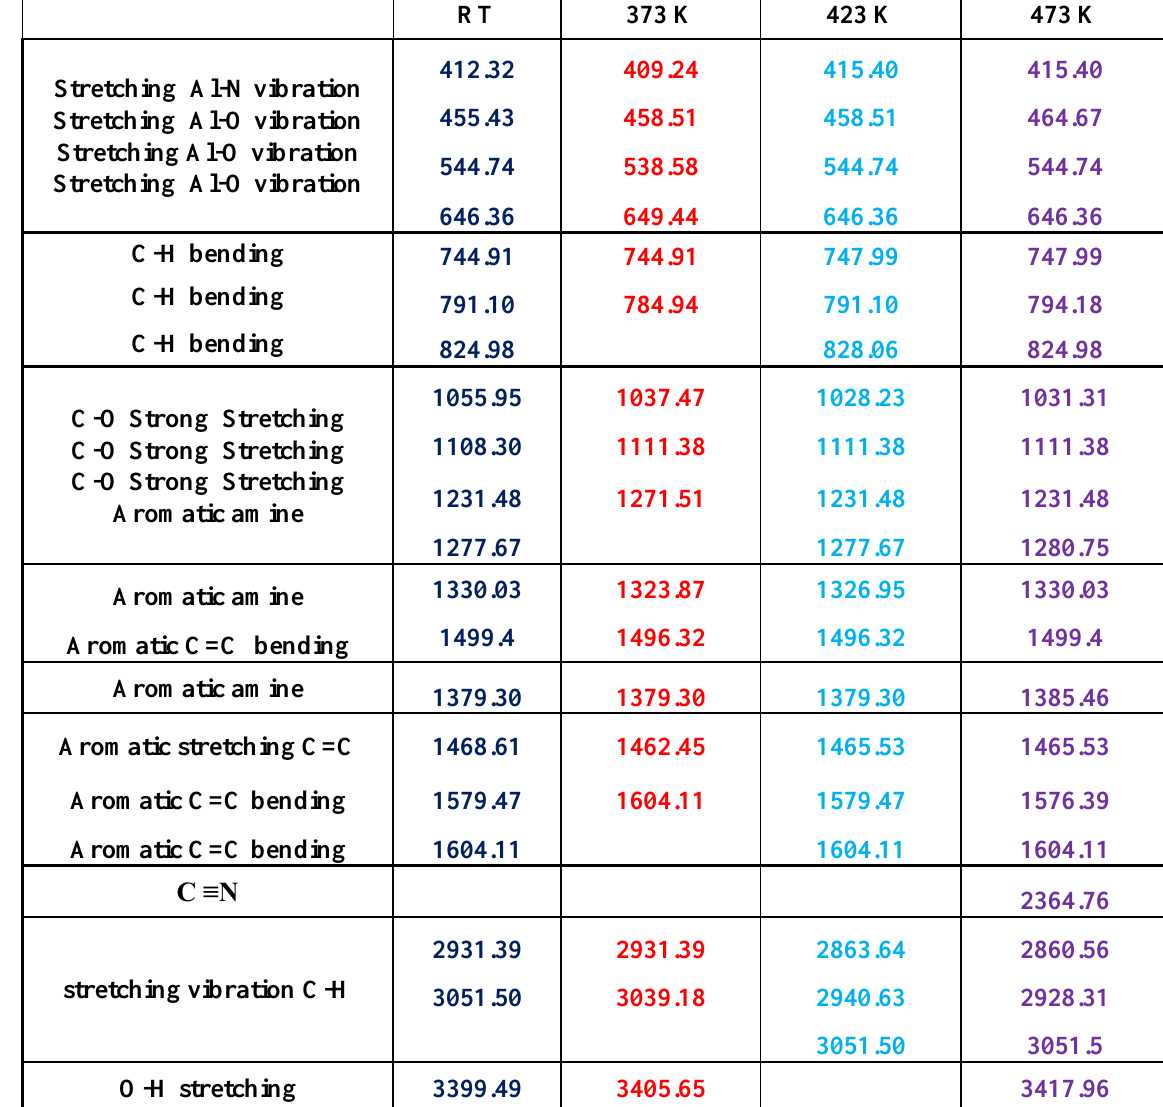
: C (100:1) treated with different annealing 3 60